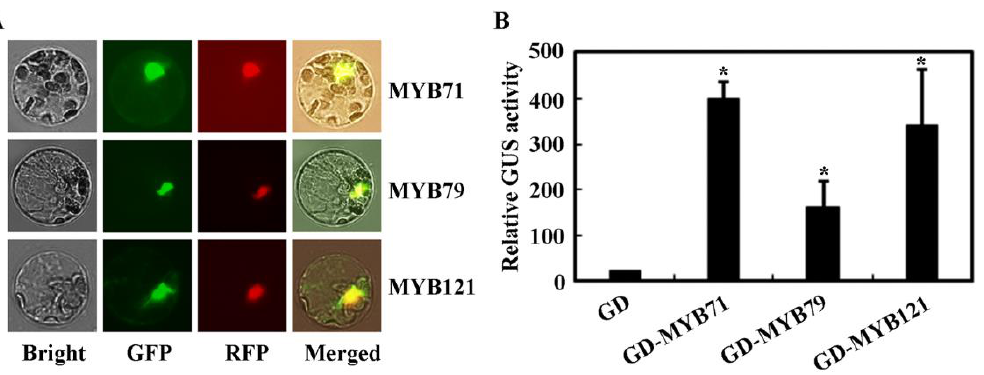
Figure 2. MYB71 and its closely related proteins MYB79 and MYB121 are transcription activators. ( A ) Subcellular localization of MYB71 , MYB79 , and MYB121 . Plasmids of the effector genes GFP-MYB71 , GFP-MYB79 , and GFP-MYB121 were co-transfected, respectively, with the nuclear marker gene NLS-RFP into Arabidopsis protoplasts. The transfected protoplasts were incubated in dark for 18 – 20 h at room temperature, then GFP and RFP fluorescence was observed under a confocal microscope. ( B ) Transcriptional activities of MYB71 , MYB79 and MYB121 . Plasmids of the effector genes GD , GD-MYB71 , GD-MYB79 , GD-MYB121 were co-transfected, respectively with the reporter gene Gal4:GUS into protoplasts. The transfected protoplasts were incubated in dark for 20 – 22 h at room temperature, the GUS activities were measured by using a microplate reader. Data represent the mean ± SD of three replicates. * Significantly different from the control ( p < 0.05).